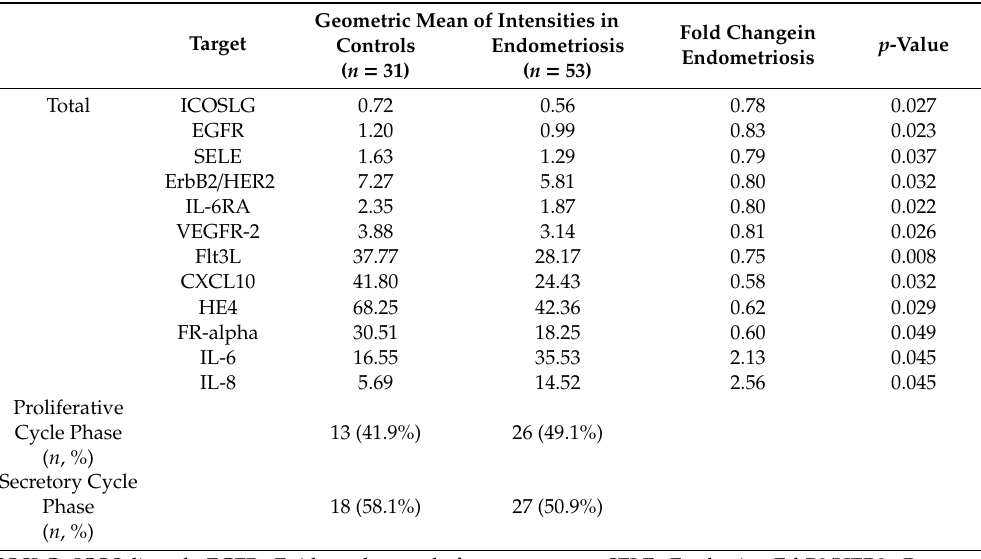
Table 2. Significant results in the comparison of target protein concentration between endometriosis patients and controls. The fold change describes the ratio of protein expression values between the two tested groups.